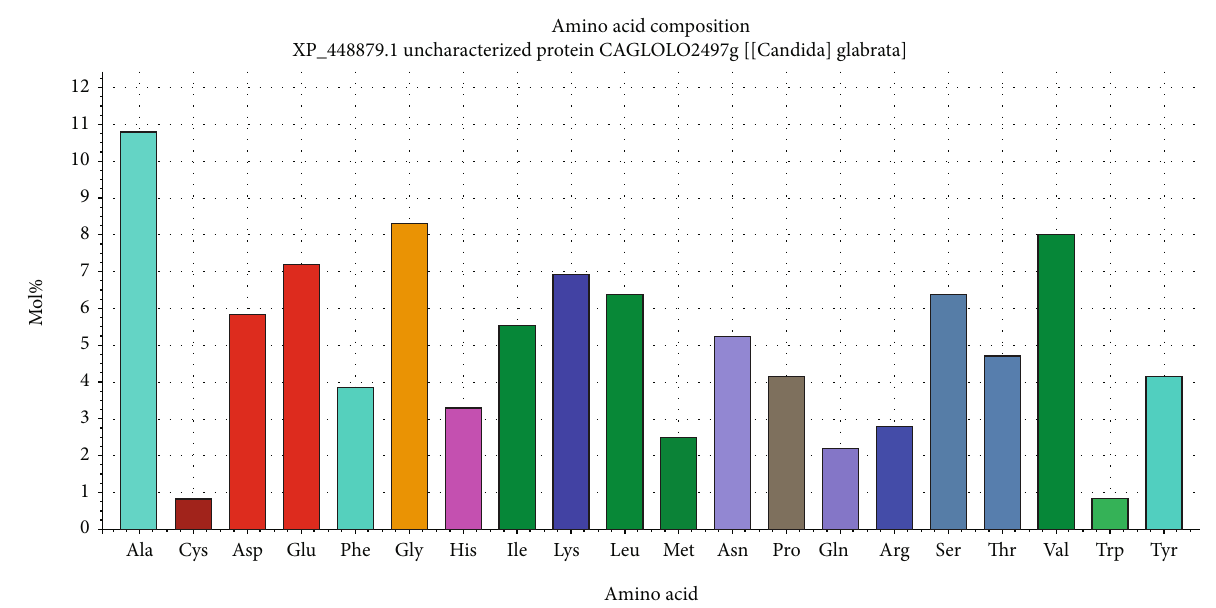
Figure 9: Graph showing amino acid composition of fructose bisphosphate aldolase protein and their molecular weights using BioEdit software 7.0.5.3.